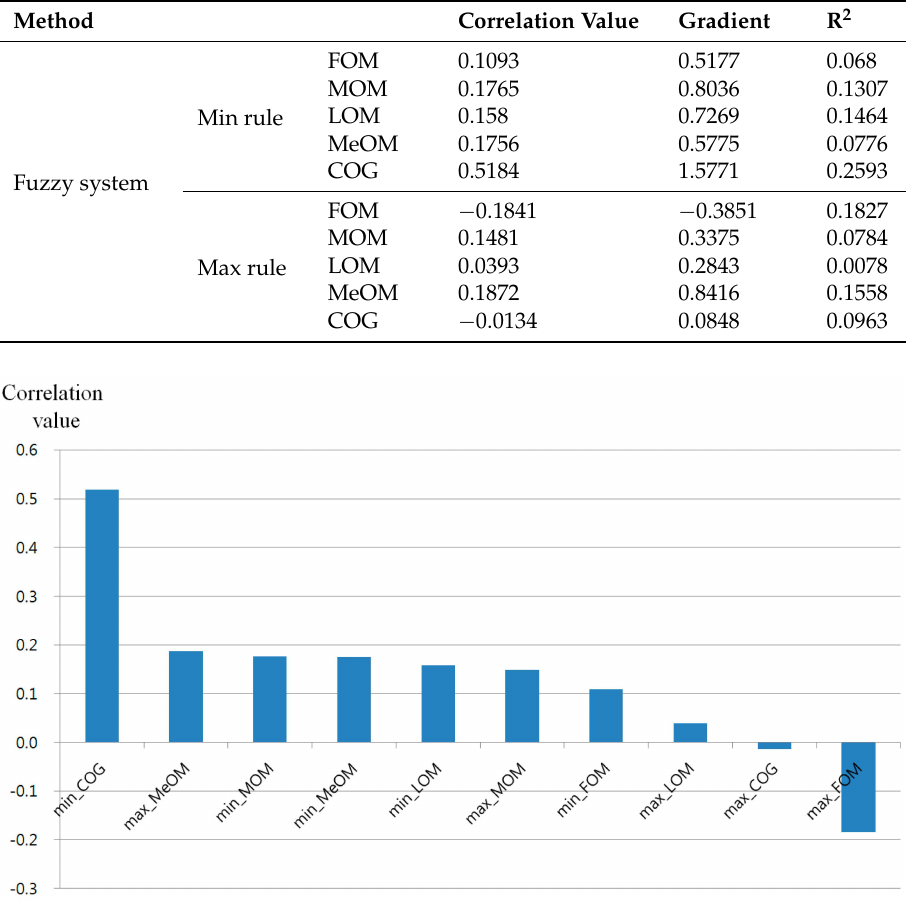
Figure 19. The correlation values between the real gaze errors and each method of defuzzification using the Min or Max